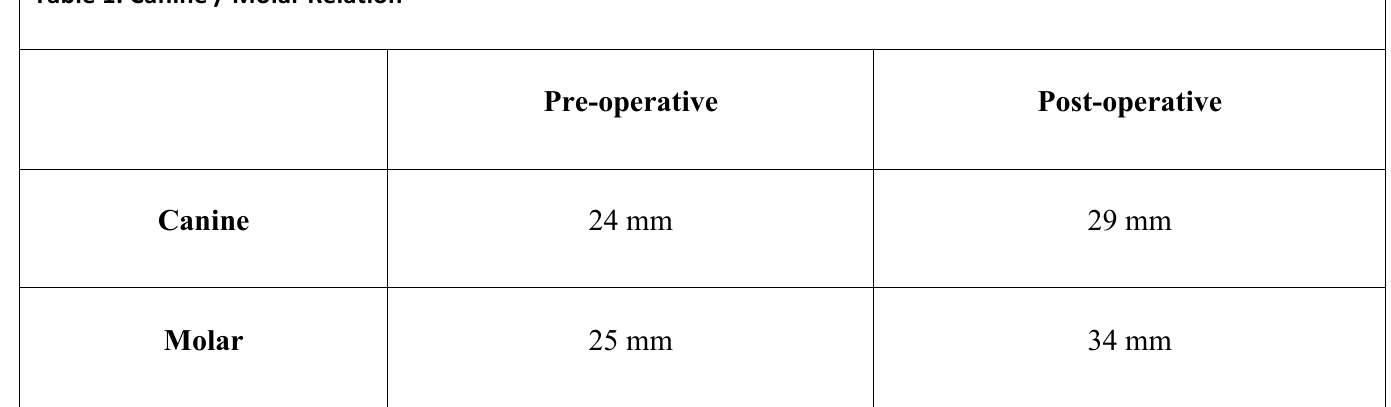
Table 1. Canine / Molar Relation